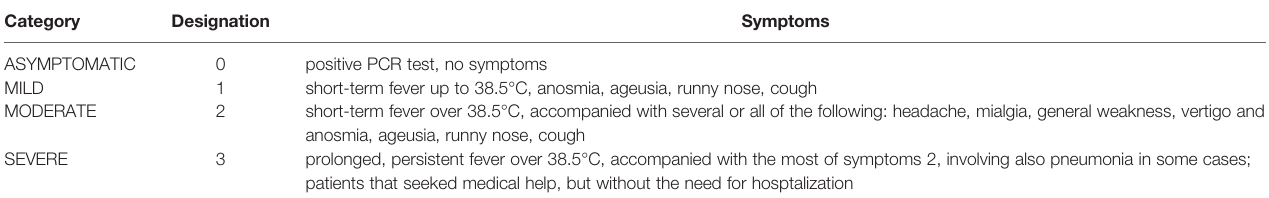
TABLE 1 | Categories of COVID-19 disease severity.